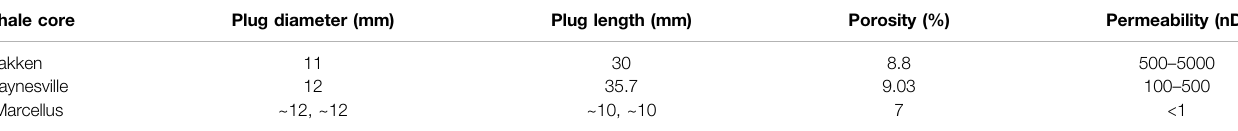
TABLE 1 | Physical properties of shale core plugs used in this